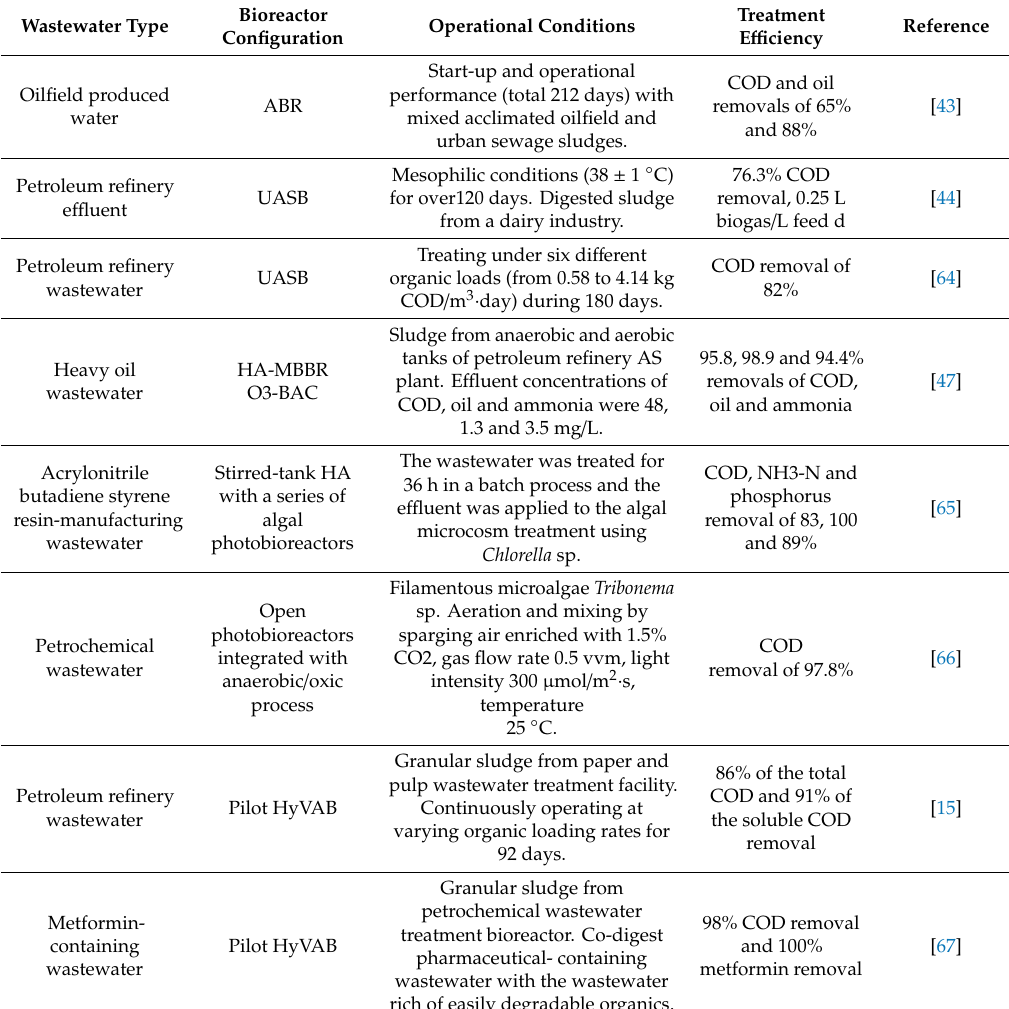
Table 3. Anaerobic and Hybrid (Anaerobic-Aerobic) Bioreactors Used for Hydrocarbon-Containing Wastewater